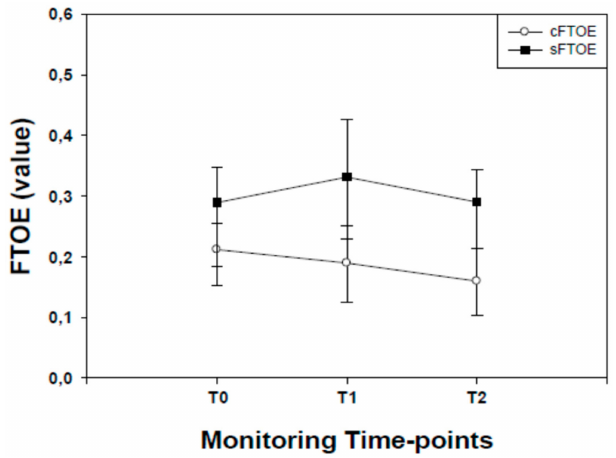
Figure 3. Cerebral (c) and splanchnic (s) fractional tissue oxygen extraction (FTOE) values recorded in late preterm infants before (T0) during (T1) and after (T2) osteopathic manipulation treatment. Data are given as median and 25–75 ◦ centiles. cFTOE values at T0 were significantly ( P < 0.001, for both) higher than those recorded at T1 and T2. sFTOE values at T0 were significantly ( P < 0.001, for both) lower than those recorded at T1 whilst no di ff erences ( P < 0.05) were found between T0 and T2 time-points. sFTOE values at T1 were significantly ( P < 0.001) higher than T2.